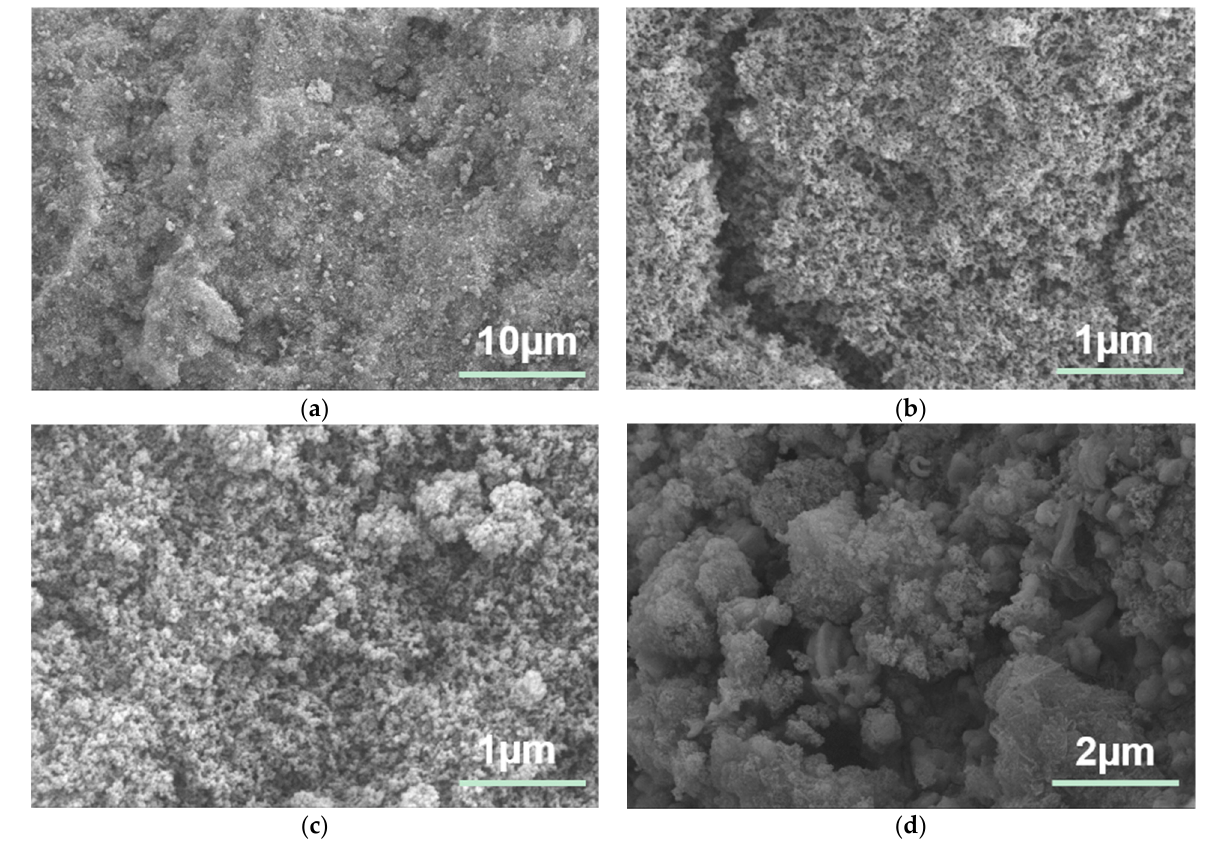
Figure 3. SEM images of S-C with HF etchings for ( a ) 0 h, ( b ) 5 h, ( c ) 10 h, and ( d ) 20 h.